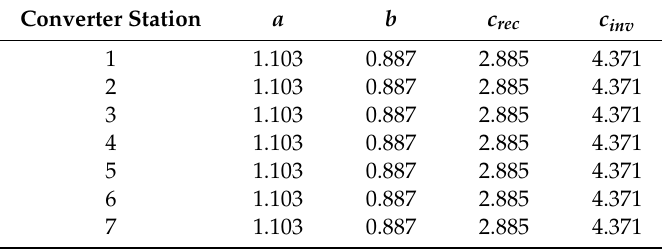
Table A31. Power losses coe ffi cients of the converter stations.